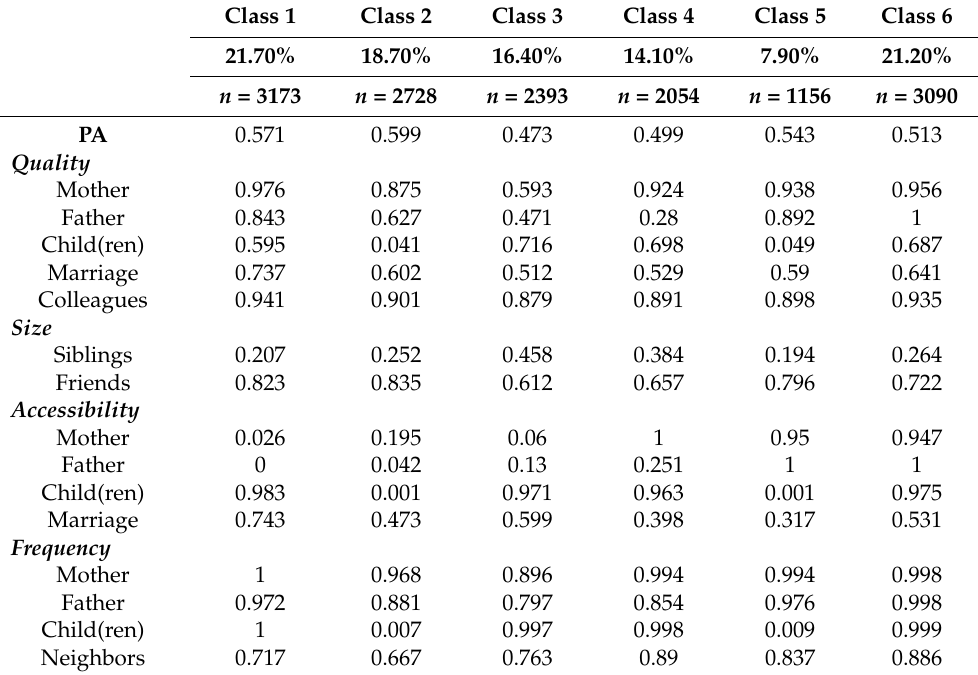
Table 3. The probabilities of the meeting criteria for six distinct subgroups of all